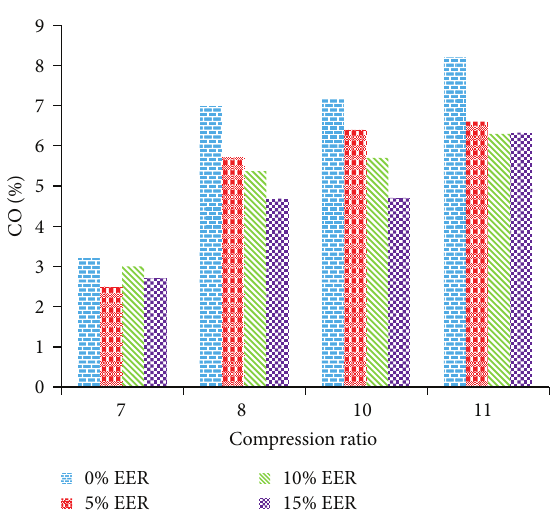
Figure 13: Effect of compression ratio on NO different EER at 1200rpm and load 14 N ⋅